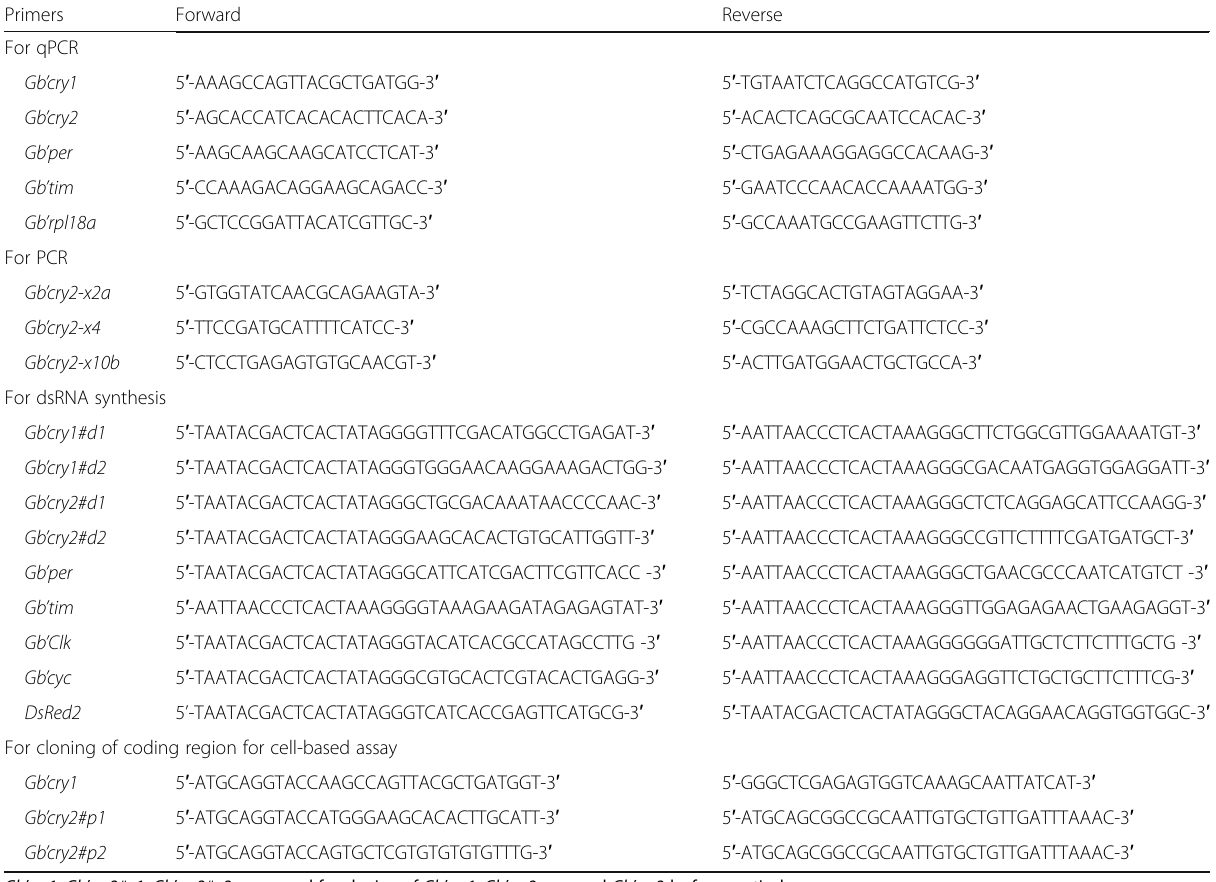
Table 1 Primers used for qPCR, PCR, dsRNA synthesis, and cloning of coding regions for cell-based assay